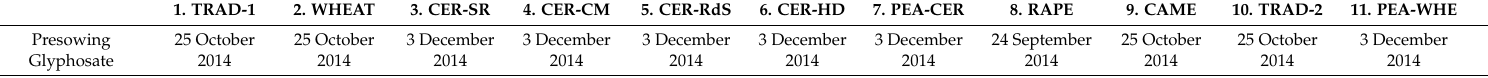
Table 3. Dates of herbicide application and chisel plow management in each